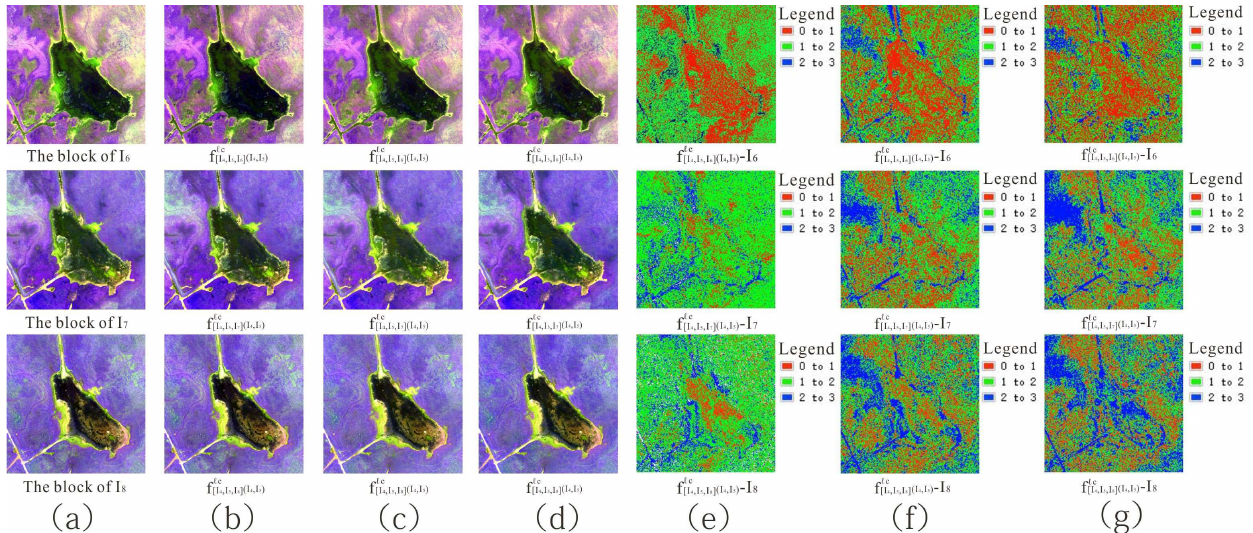
Figure 18. ( a ) Initial image ( b – d ) visual effect and ( e – g ) pixel error between block interpolated result and reference block using separable convolution kernel sizes 11, 13, and